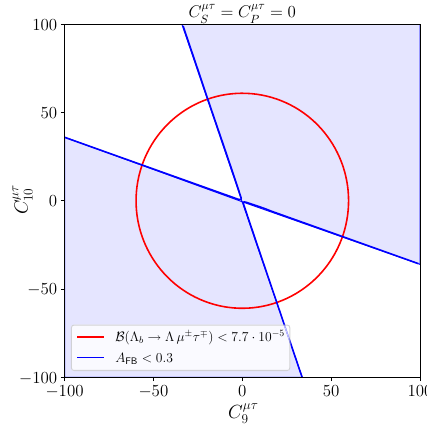
Fig. 4 Illustration of how the forward–backward asymmetry provides orthogonal constraints to the branching ratio of (cid:2) b → (cid:2)μ − τ + . The shaded area present the allowed region for an upper limit A compared to an upper limit for the branching ratio of 7 . 7 × 10 − 5 Fig. 4, the information on A of the allowed space in the C